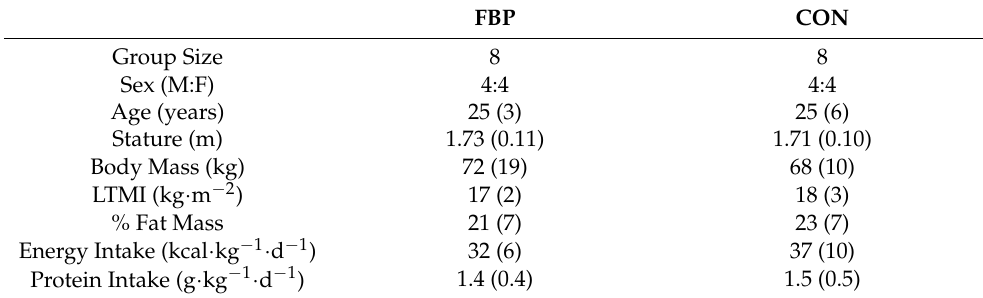
Table 2. Participant baseline characteristics.